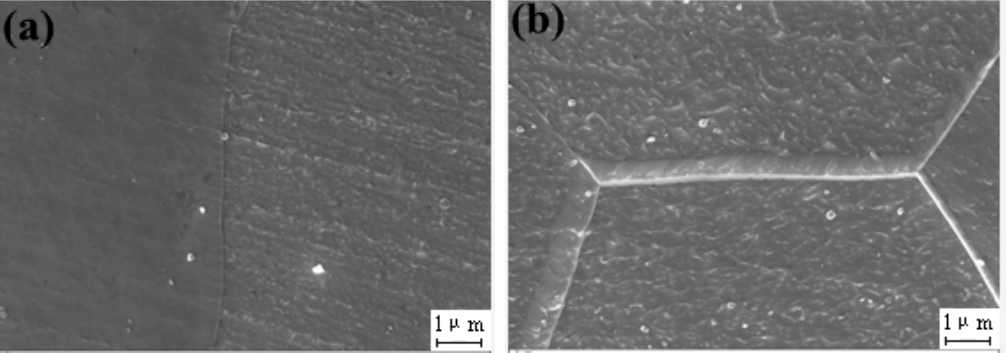
Figure 4. Distribution of precipitates in the hot-rolled band ( a ) and annealed sheets ( b ) (SEM).